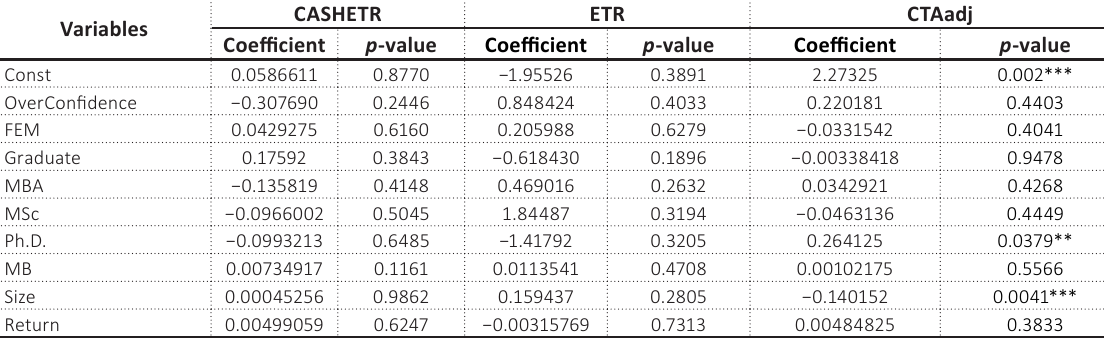
Table 6. Personal